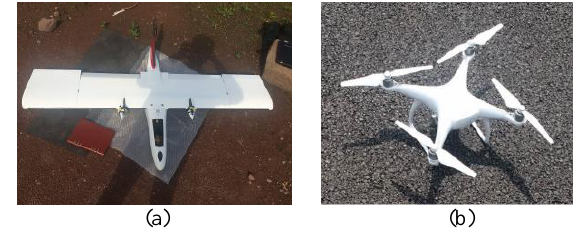
Figure 2. (a) AI Bird KC-1600 Sky Hawk UAV model and (b)